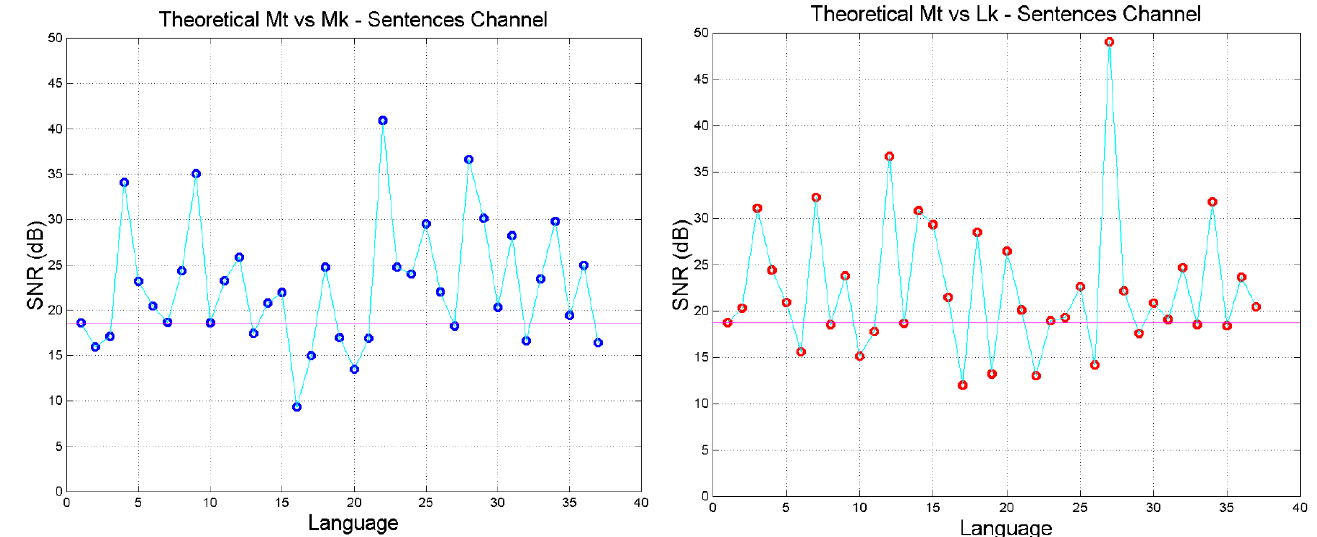
Figure 4. Sentences cross-channel theoretical signal-to-noise-ratio Γ dB in the indicated languages. Languages are ordered according to Table 1. ( Left panel ): Matthew versus Mark; ( Right panel ): Matthew versus Luke. The magenta line corresponds to Greek (language no.1). In these figures, and also in the following, the continuous lines serve for guiding eyes.